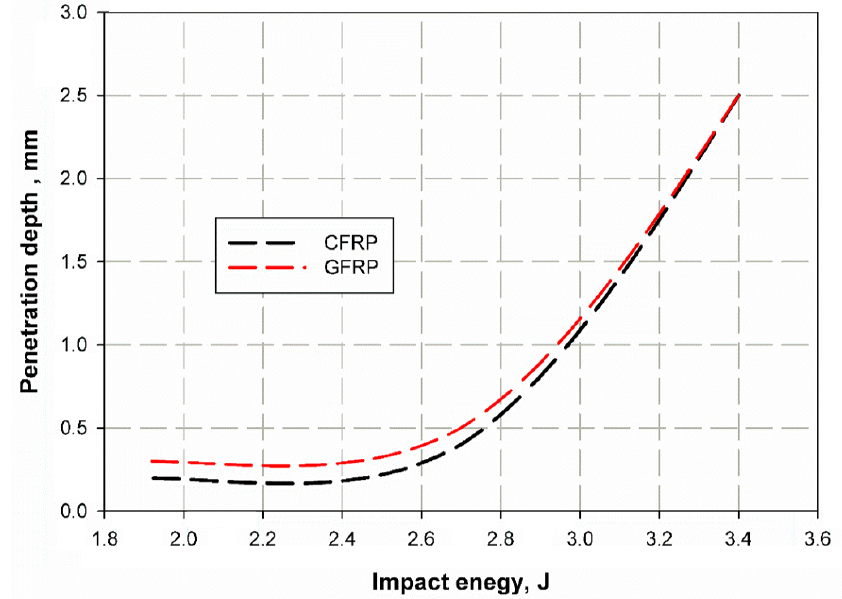
Figure 19. Depth of indentations in the drop weight impact test.